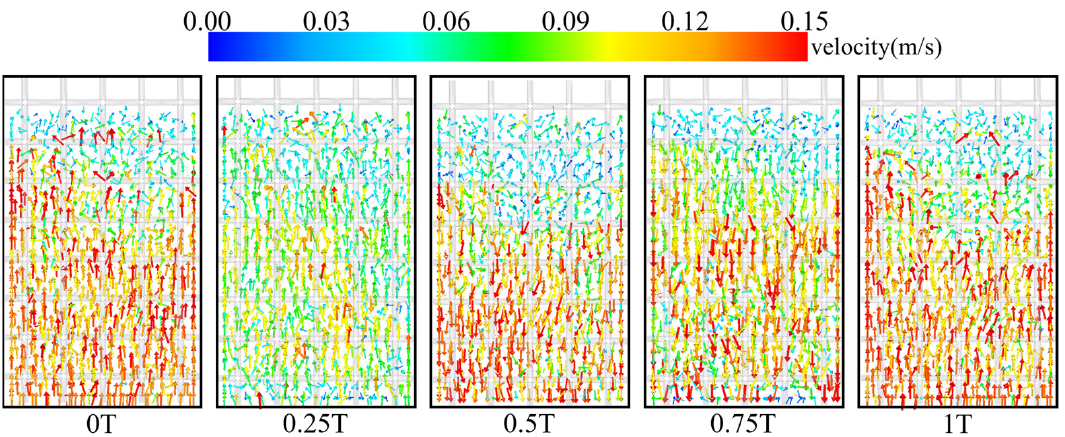
Figure 11. Particle motion in the obstacle grid particle damper.